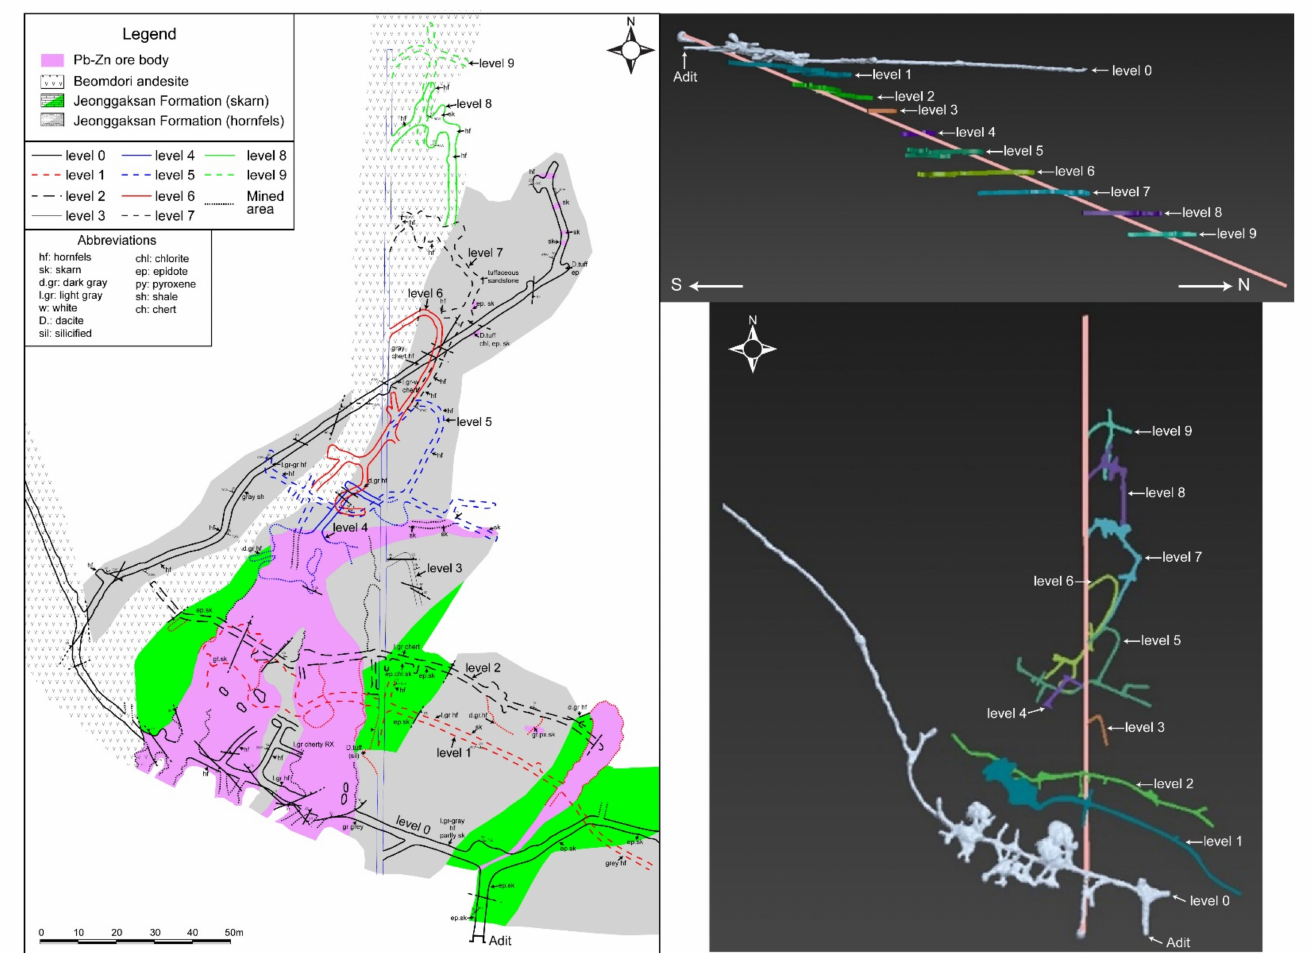
Figure 14. 2D underground map (modified after [3]) (left) and 3D map (right) showing the geology and ore body